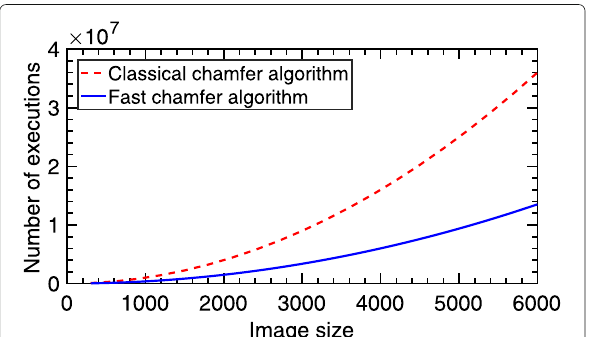
Fig. 10 Performances of the classical and proposed chamfer algorithms